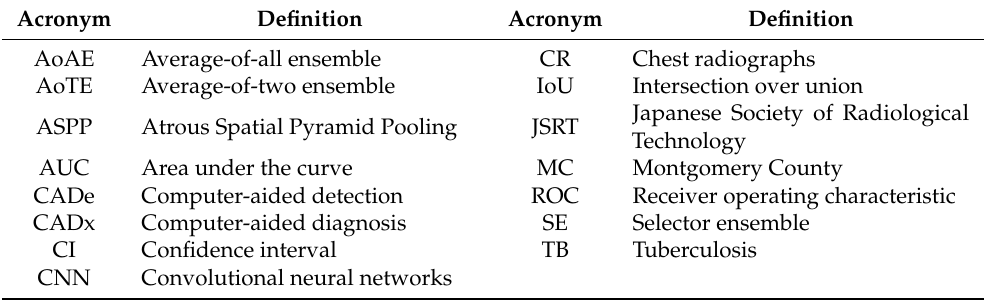
Table 1. List of acronyms used in the paper.